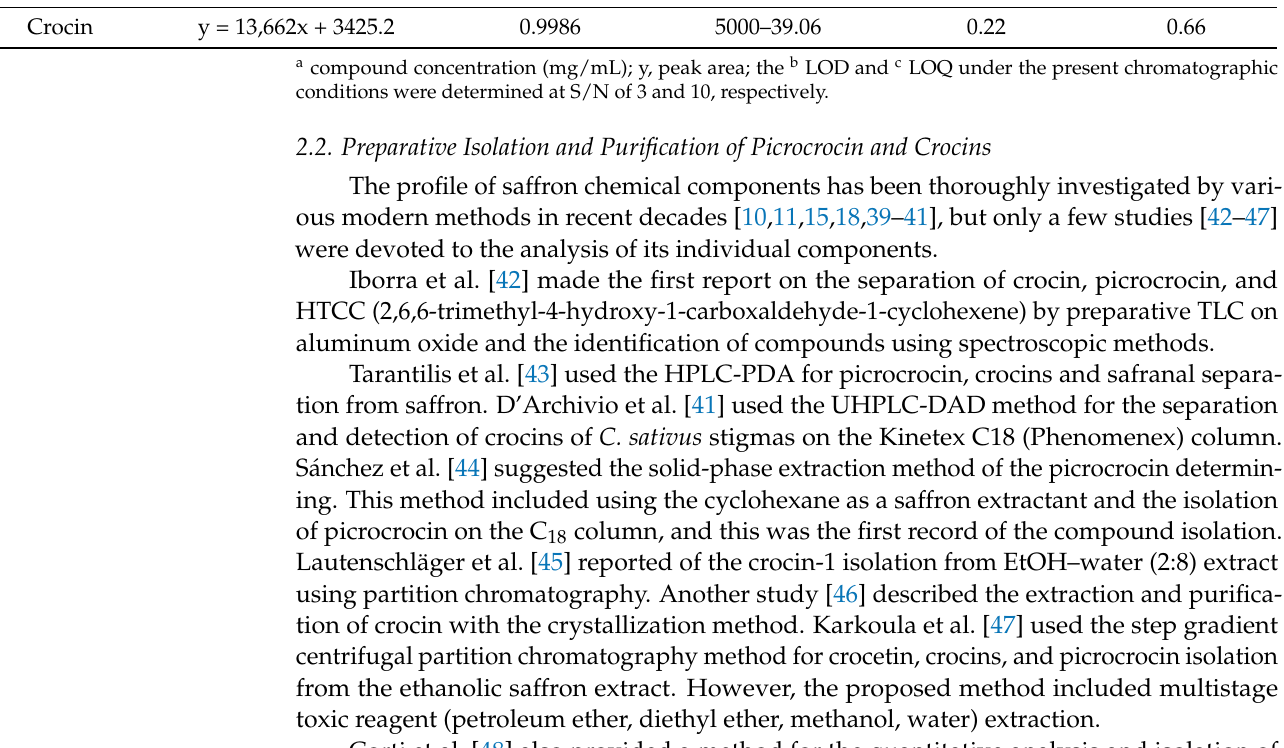
Table 2. The data of calibration curve, LOD, and LOQ of crocin of the proposed HPTLC method.